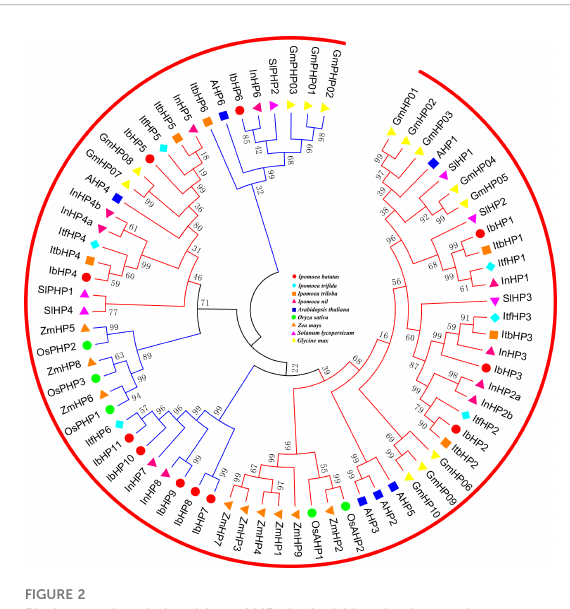
FIGURE 1 Phylogenetic relationships of HK(L)s in Arabidopsis, rice, maize, tomato, soybean and sweet potato. The phylogenetic tree was constructed using the neighbor-joining method with MEGA 7.0 software. HK(L)s in various species were marked with different labels and diverse subgroups of HK(L)s were highlighted by different